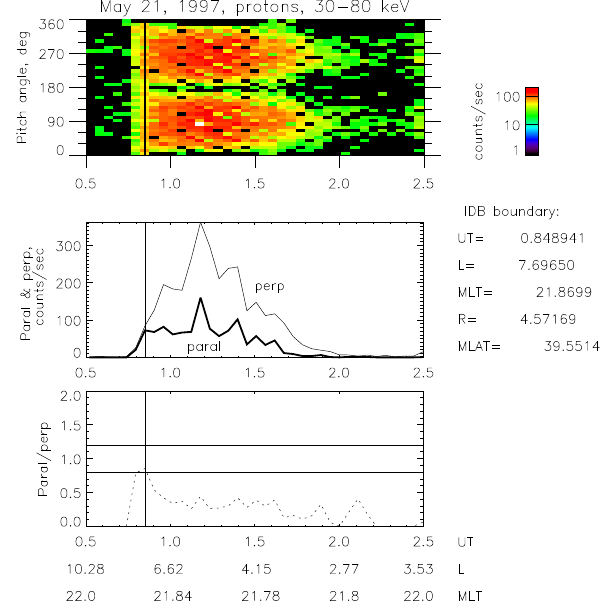
Fig. 2. (top panel) Polar CAMMICE/MICS measurements of pro- ton pitch angle distributions in the energy range of 31–80keV, (mid- dle panel) parallel (thick line) and perpendicular (thin line) count rates, and (bottom panel) the ratio between the parallel and perpen- dicular count rates for 21 May 1997, 00:30–02:30 UT. The position of IDB is marked by a vertical line at all three